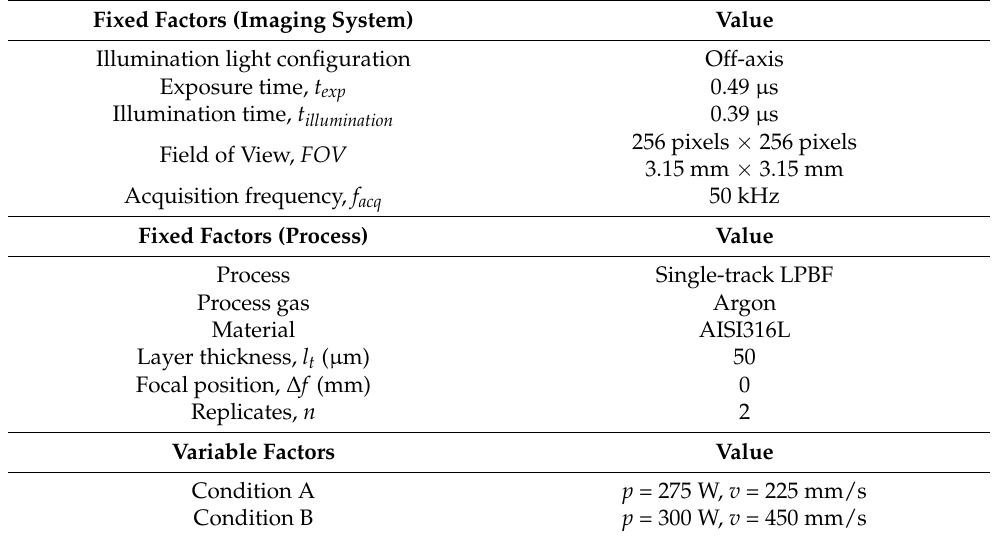
Table 6. Fixed and variable factors for the experimental campaign to determine molten pool surface oscillations and geometrical